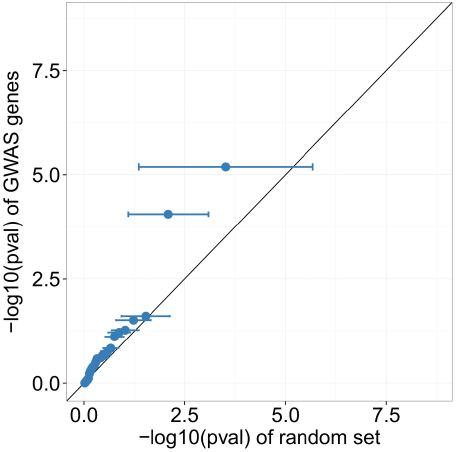
Figure 2. GWAS genes identified from discovery SNPs appear to be enriched for differential expression. X -axis values of dots indicate the mean 2 log10(pval) from 10,000 randomly permuted sets, and error bars indicate one standard deviation from the mean in these permutations.